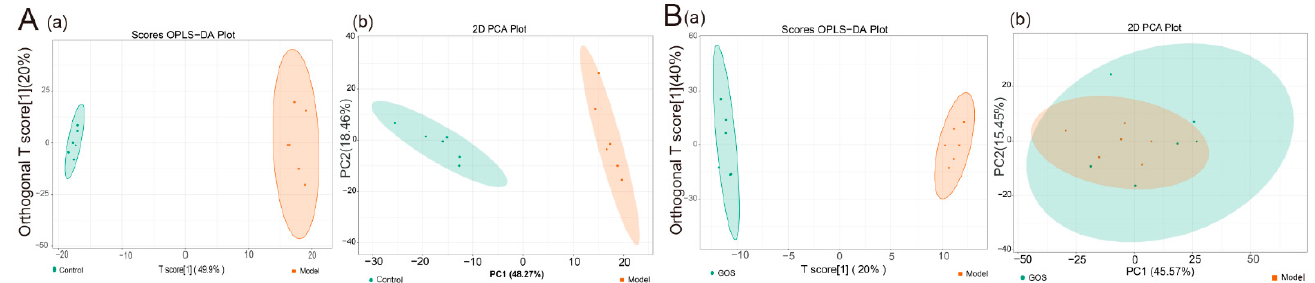
Figure 5. ( A ) OPLS-DA score plot ( a ) and PCA plot ( b ) of liver tissue samples from the Control group and the Model group; ( B ) OPLS-DA score plot ( a ) and PCA plot ( b ) of liver tissue samples from the GOS group and the model group